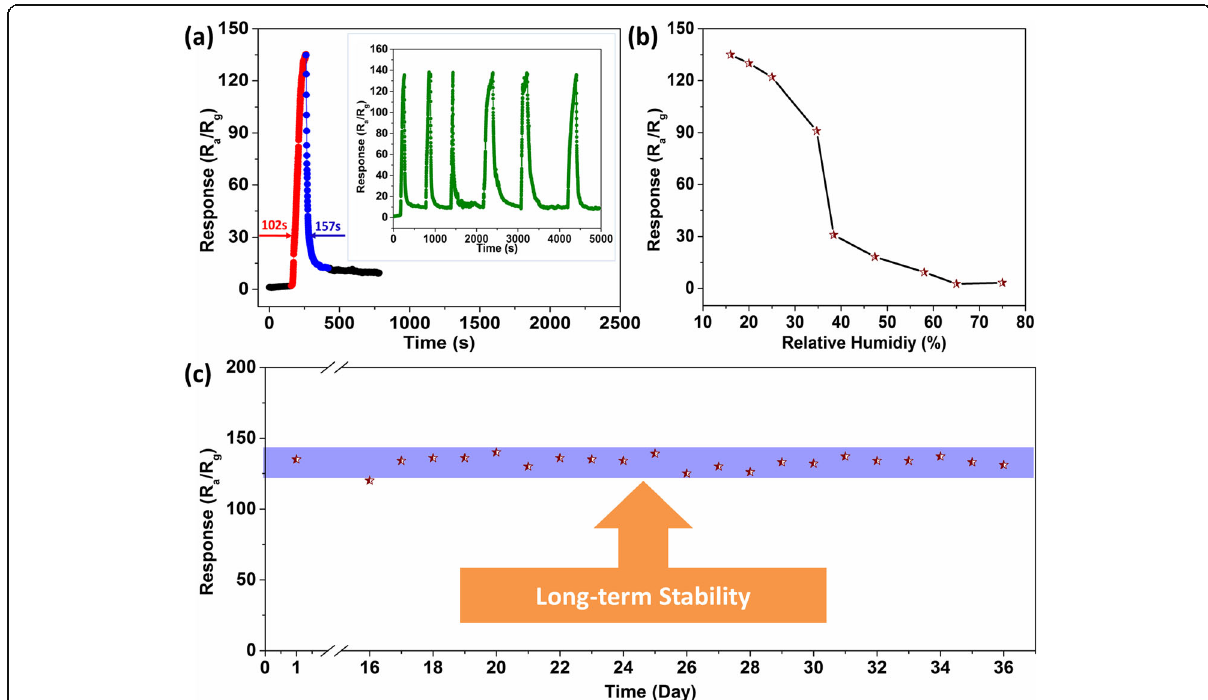
Fig. 9 a The response – recovery of the 5%Ag-In 2 O 3 toward 1 ppm HCHO gas for 6 cycles at 30 °C. b Responses of 5%Ag-In 2 O 3 sensor toward 1 ppm of HCHO under different humidity conditions at 30 °C. c Long-term stability tests of 5%Ag-In 2 O 3 sensor toward 1 ppm HCHO after continuous evaluation for 36 days at 30 °C